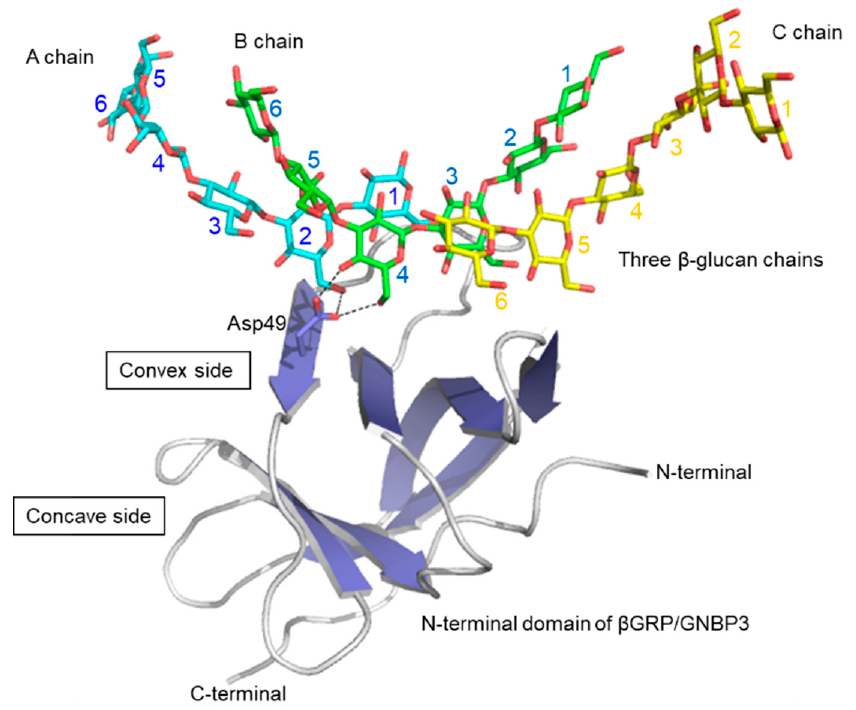
Figure 4. Crystal structure of Bombyx mori β GRP/GNBP3 N-terminal domain bound to three β -glucan chains [38]. Proteins are shown in the surface model and three laminarihexaose chains are in stick representation. As an example of β -glucan-interacting residues, Asp49 side chain is shown in stick representation, interacting with A and B chains.